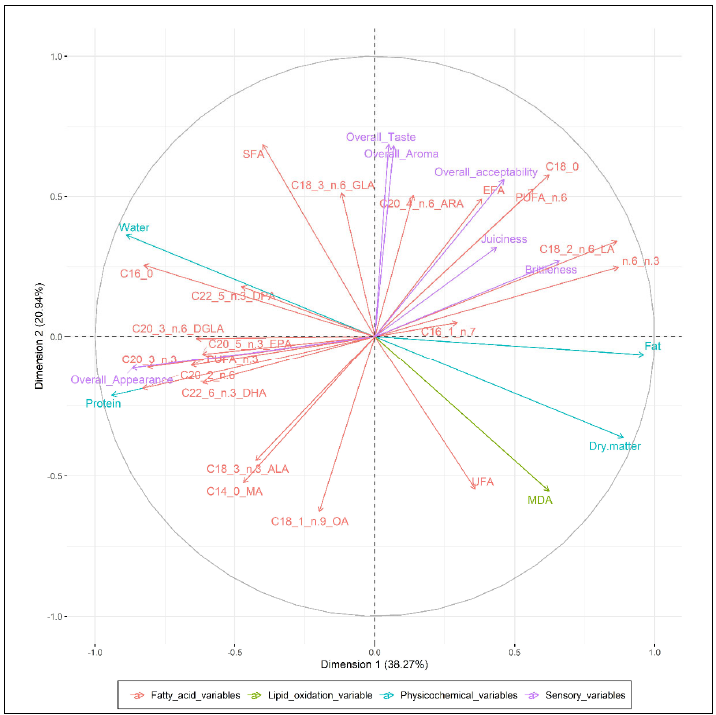
Figure 5. Quantitative variables of multiple factor analysis used for evaluation of breast and thigh meat samples. C: control group; FF10: broilers fed with a diet enriched with supplementation of 10% FF; FF10 + AE: broilers fed with a diet enriched with 10% supplementation of FF supported with 0.2% agrimony extract; SFA: saturated fatty acids; GLA: gamma ‐ linolenic acid; ARA: arachidonic acid; EFA: essential fatty acids; PUFA: polyunsaturated fatty acids; LA: linolenic acid; UFA: unsaturated fatty acids; MDA: malondialdehyde; OA: oleic acid; MA: myristic acid; ALA: alfa ‐ linolenic acid; DHA: docosahexaenic acid; EPA: eicosapentaenic acid; DGLA: dihomo ‐ gamma linolenic; DPA: docosapentaenic acid.